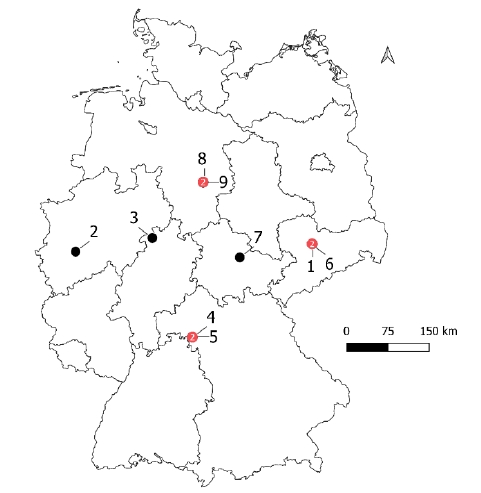
Figure A1. Map of locations of study fields across Germany. Numbers correspond to field numbers in Table